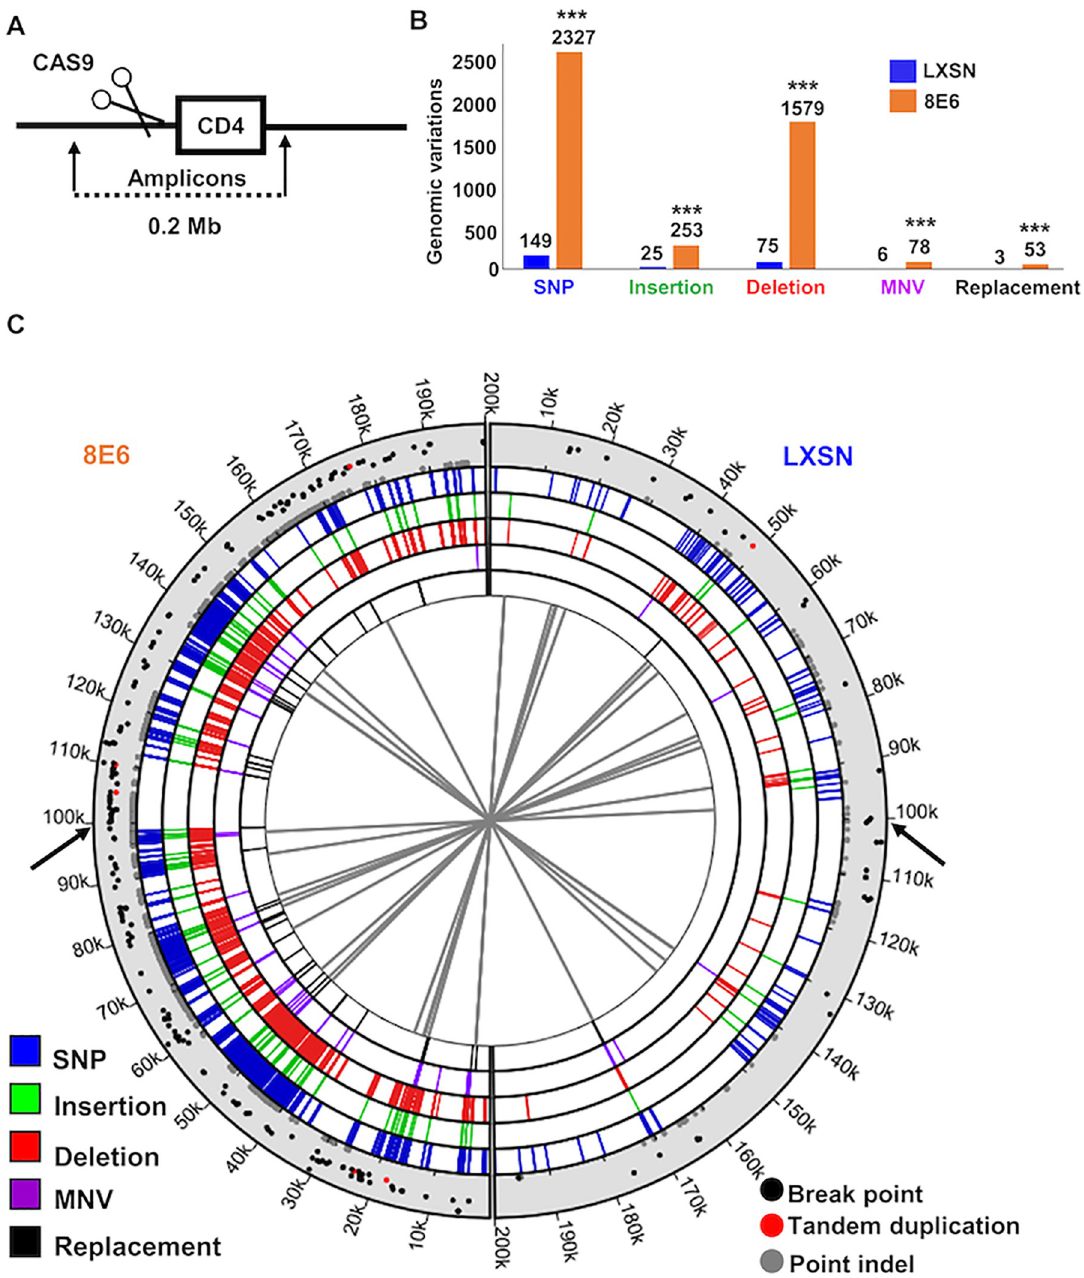
Fig 7. Beta-HPV 8E6 increases genomic instability during DSB repair. (A) Schematic of the placement of CAS9 induced DSB along the sequenced portion of the genome. (B) Genomic variations grouped by types of mutational events in HFK LXSN and HFK 8E6. Each group of genomic variations and total number of variations were compared between HFK LXSN and HFK 8E6. (C) Circos plot of DNA mutations in HFK LXSN (right side) and HFK 8E6 cells (left side). Black arrows indicate CAS9 cutting sites. The innermost circle displays connections between identical genomic rearrangements. The location of genomic rearrangements colored by types of genomic variations are shown in five concentric circles (blue represents SNP, green represents insertion, red represents deletion, purple represents MNV, and black represents replacement). Scatter plot in the outermost circle displays breakpoints (black), tandem duplications (red), and point indels (grey), in which proximity to the outer edge represents high variant ratio. SNP, single nucleotide polymorphism. MNV, multi-nucleotide variation. Statistical differences between cell lines were measured using a Students’ T-test. ��� indicates p < 0.001.